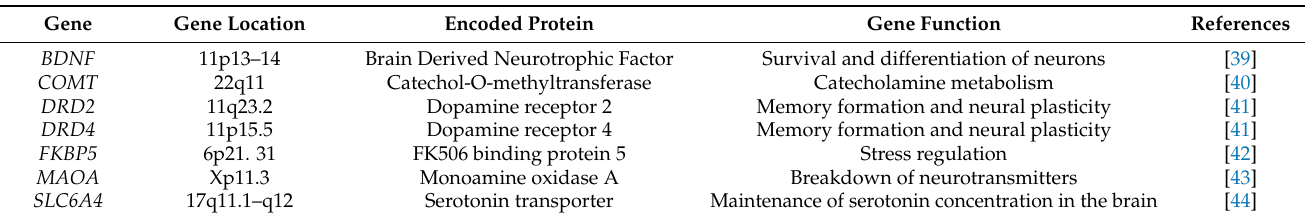
Table 1. Summary of candidate genes for both PTSD and